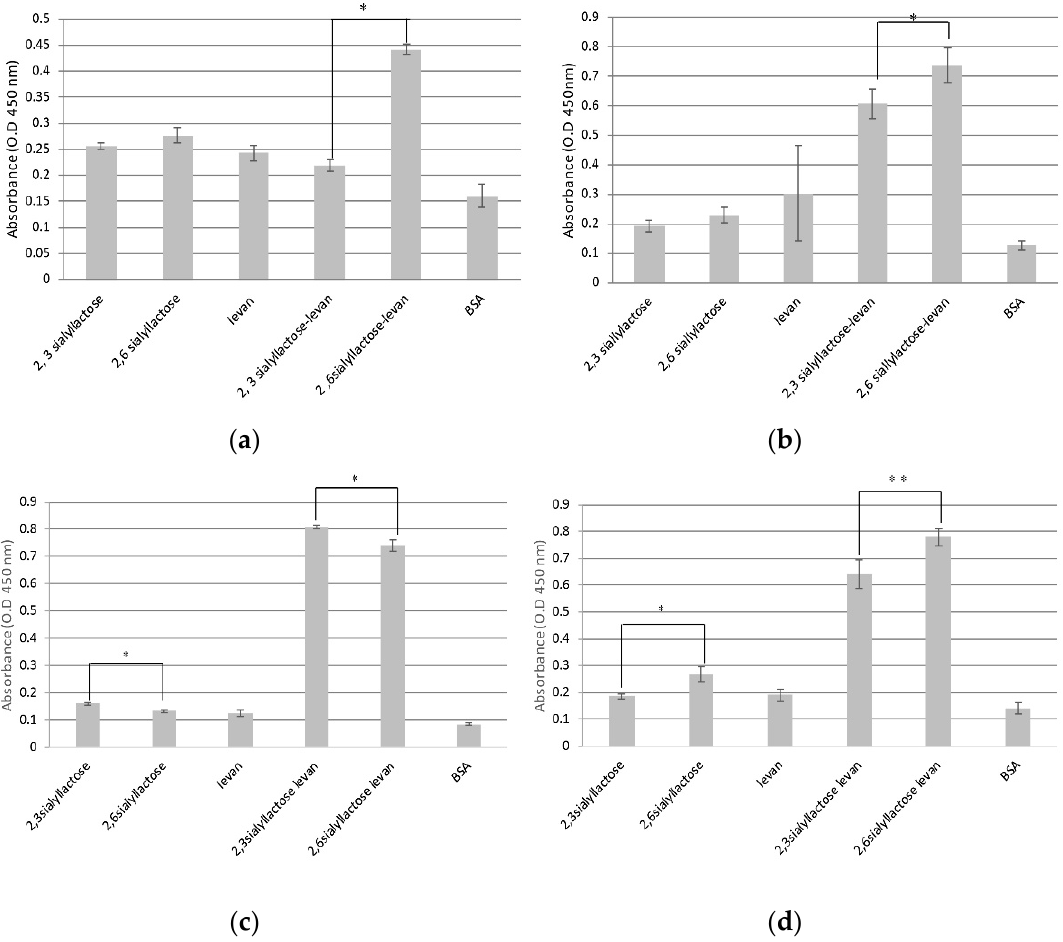
Figure 2. Binding affinity of polymers to hemagglutinin (HA) ( a ), influenza A virus (A/California 07/2009 (H1N1)) ( b ), Maackia amurensis lectin II ( c ), and Sambucus nigra lectin ( d ), as determined using a modified ELISA assay (* p < 0.05, ** p < 0.005).